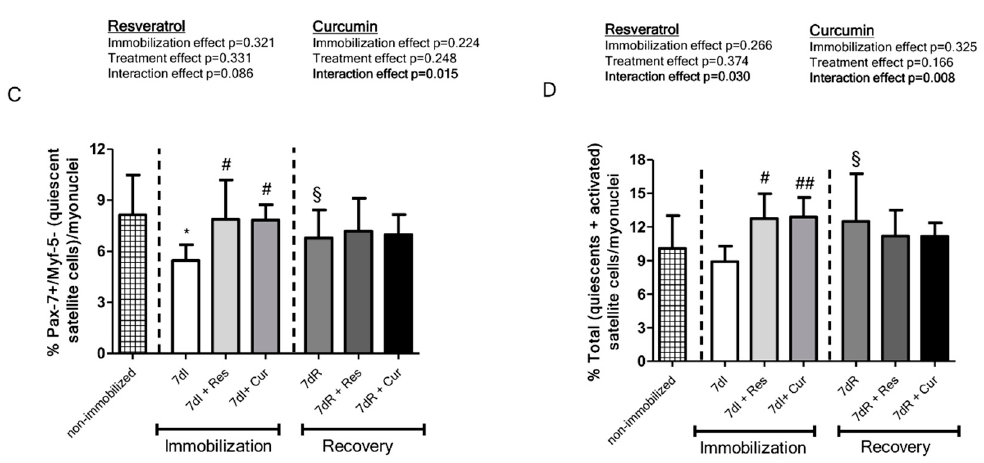
Figure 4. ( A ) Mean values and standard deviation of the percentage of satellite cells (alpha-7 integrin + /CD34 + ) measured by FACS analyses in the limb muscles of the different study groups of mice. Definition of abbreviations: α 7, alpha-7 integrin; g, grams; I, immobilization; R, recovery; Res, resveratrol; Cur, curcumin. Statistical significance is represented as follows: *, p < 0.05 between the 7dI animals and non-immobilized mice; §, p < 0.05 between the 7dI and 7dR groups of animals; # , p < 0.05 for any group of pharmacologically treated mice (resveratrol or curcumin) compared to their respective group (7dI or 7dR mice). The effect of immobilization and treatment and interaction effects are also indicated as actual p values for each variable. ( B ) Mean values and standard deviation of the percentage of activated satellite cell counts as identified by the number of Pax-7/Myf-5-positive cells in the gastrocnemius muscle of the different study groups of mice. Definition of abbreviations : Pax-7, paired box-7; Myf-5, myogenic factor 5; I, immobilization; R, recovery; Res, resveratrol; Cur, curcumin. Statistical significance is represented as follows: **, p < 0.01 between 7dI animals and non-immobilized mice; # , p < 0.05 for any group of pharmacologically treated mice (resveratrol or curcumin) compared to their respective group (7dI or 7dR mice). The effect of immobilization and treatment and interaction effects are also indicated as actual p values for each variable. ( C ) Mean values and standard deviation of the percentage of quiescent satellite cell counts as identified by the number of Pax7-positive cells (Myf-5-negative) in the gastrocnemius muscle of the different study groups of mice. Definition of abbreviations: Pax-7, paired box-7; Myf-5, myogenic factor 5; I, immobilization; R, recovery; Res, resveratrol; Cur, curcumin. Statistical significance is represented as follows: *, p < 0.05 between 7dI animals and non-immobilized mice; §, p < 0.05 between the 7dI and 7dR groups of animals; # , p < 0.05 for any group of pharmacologically treated mice (resveratrol or curcumin) compared to their respective group (7dI or 7dR mice). The effect of immobilization and treatment and interaction effects are also indicated as actual p values for each variable. ( D ) Mean values and standard deviation of the percentage of total satellite cell counts as identified by the number of quiescent and activated satellite cells in the gastrocnemius muscle of the different study groups of mice. Definition of abbreviations: I, immobilization; R, recovery; Res, resveratrol; Cur, curcumin. Statistical significance is represented as follows: §, p < 0.05 between the 7dI and 7dR groups of animals; # , p < 0.05 and ## , p < 0.01 for any group of pharmacologically treated mice (resveratrol or curcumin) compared to their respective group (7dI or 7dR mice). The effect of immobilization and treatment and interaction effects are also indicated as actual p values for each variable.